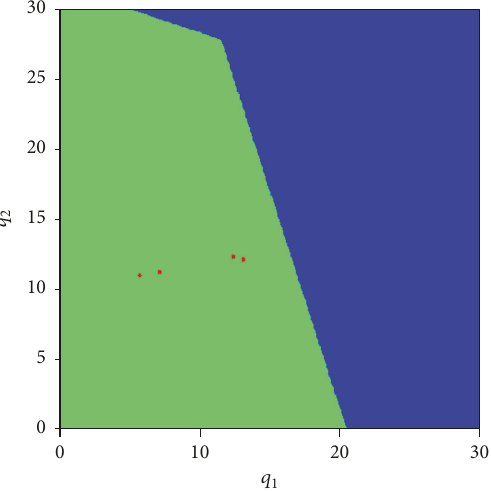
Figure 25: Basins of attraction, 𝛼 = 0.3 , 𝛽 = 0.25 , and 𝑞 3 = 10 .